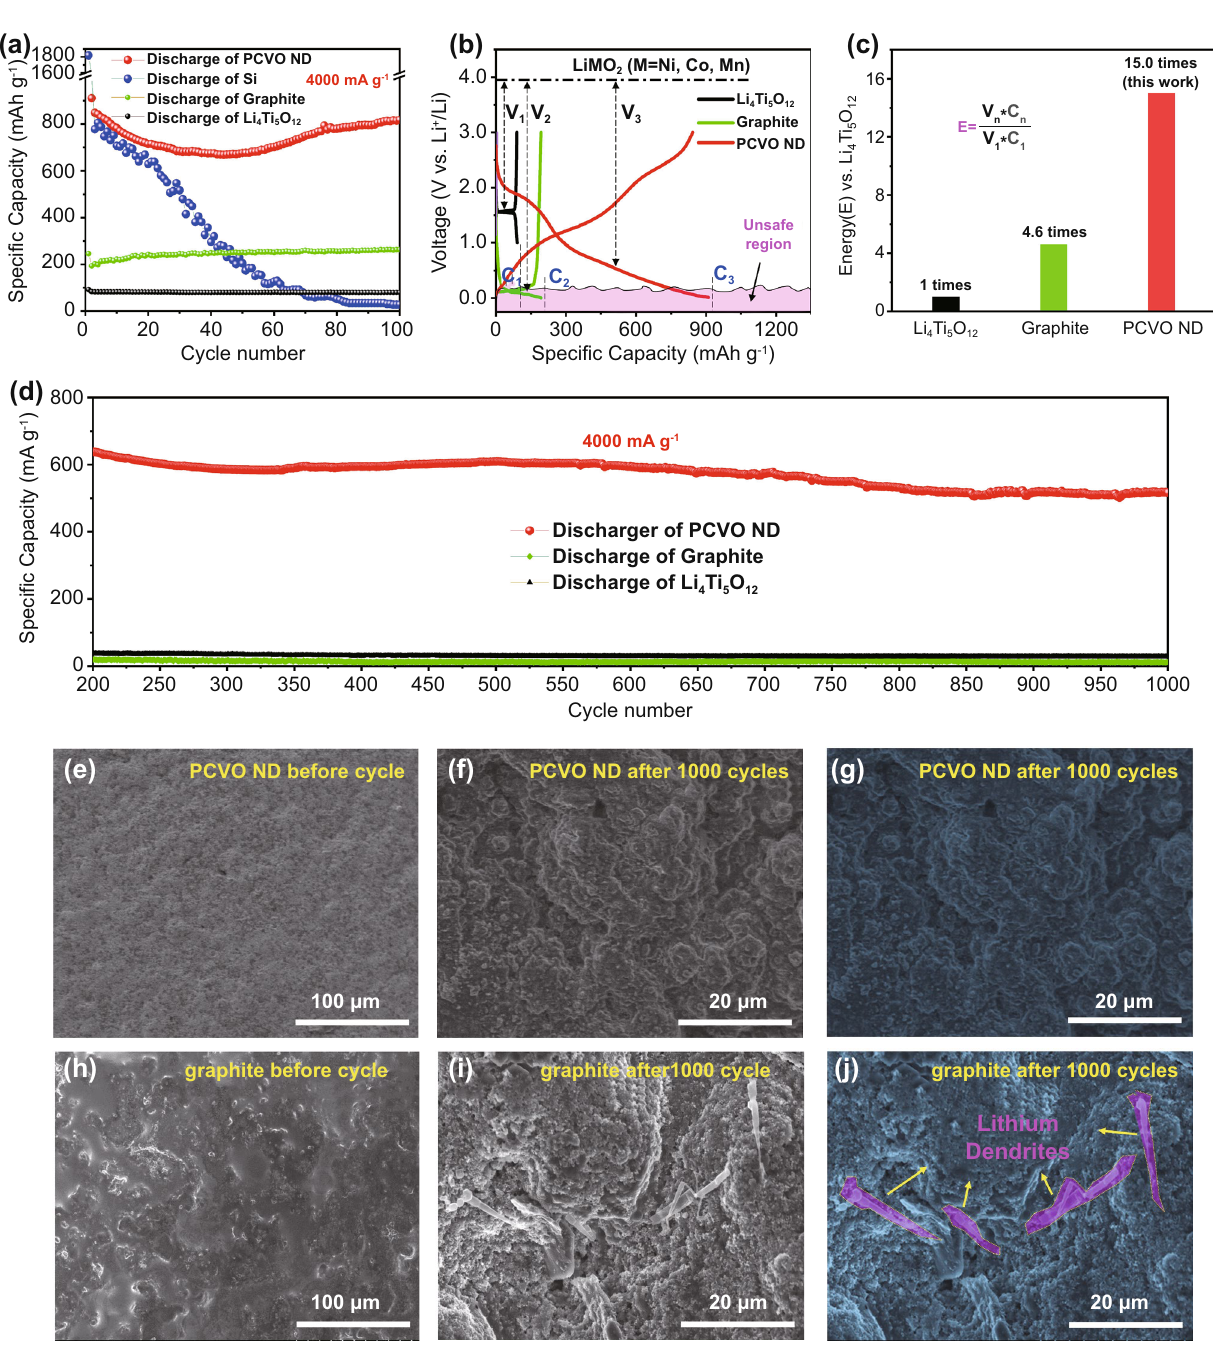
Fig. 5 a The cycling performance of PCVO ND and commercial graphite, Si and Li 4 Ti 5 O 12 anode materials at 400 mA g −1 . b The poten- tial versus capacity plots of PCVO ND, commercial graphite, and Li 4 Ti 5 O 12 at 400 mA g −1 . c The energy density comparison of PCVO ND, commercial graphite, and Li 4 Ti 5 O 12 . d The long-term cycling performance of PCVO ND, Li 4 Ti 5 O 12 , and graphite at 4000 mA g −1 from the 200th to 1000th cycle. e SEM image of PCVO ND electrode before cycling. f and g SEM images of PCVO ND electrode after 1000 cycles at 4000 mA g −1 . h SEM image of graphite electrode before cycling. i and j SEM images of graphite electrode after 1000 cycles at 4000 mA g